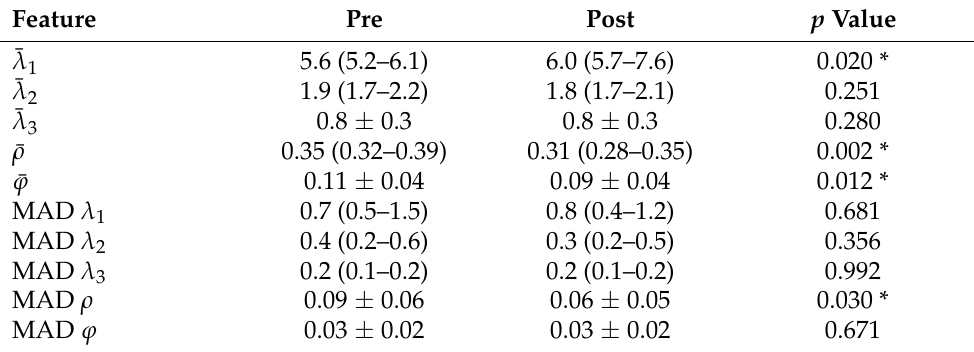
Table 2. Pre- and post-PVI morphological features, and average mean absolute deviation (MAD) about mean for the whole study population (50 subjects). Data are mean ± standard deviation or median (interquartile range). * p -value < 0.05 by paired Student’s t -test or Wilcoxon–Mann–Whitney